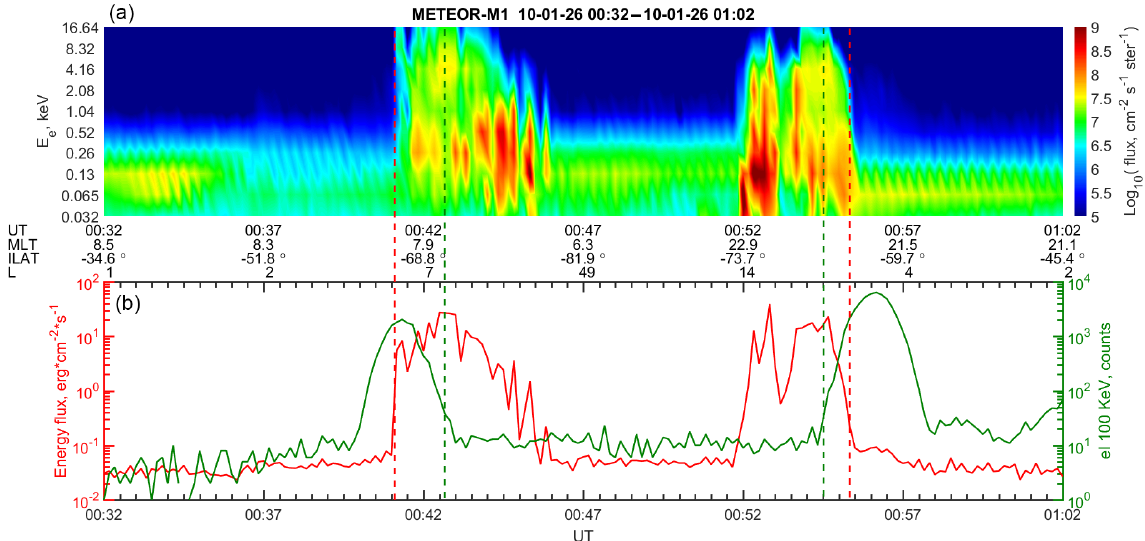
Figure 3. An example of observation of the polar boundary of ORB inside the auroral oval at AE < 150nT. The notations are the same as in Fig. 1.